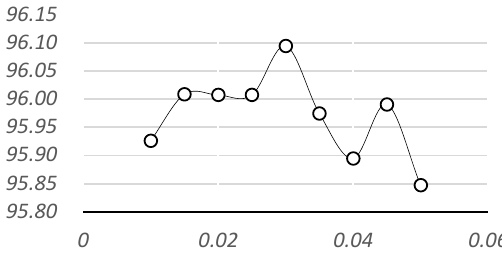
Figure 4. Overall accuracy (%) obtained by proposed method using different C value.